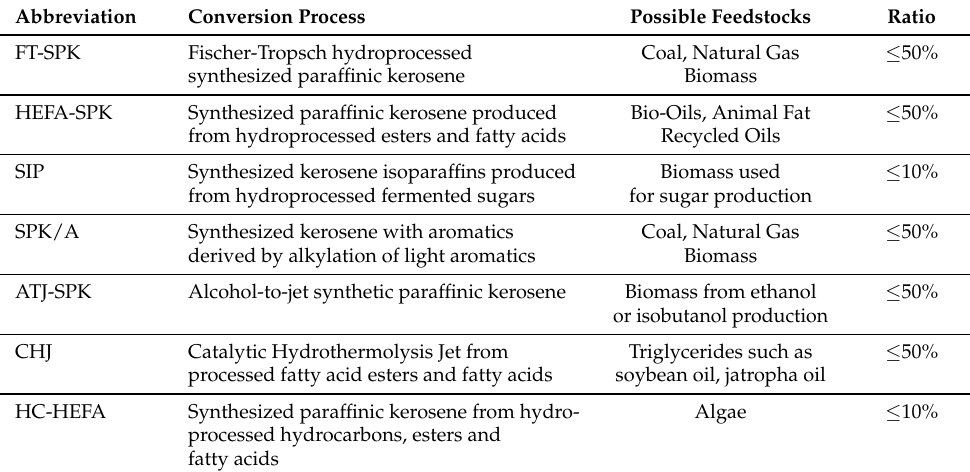
Table 1. Certified processes for Sustainable aviation fuel